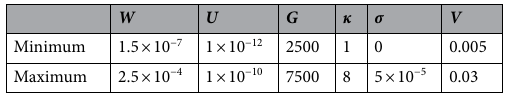
Table 1. Parameter range for lubrication